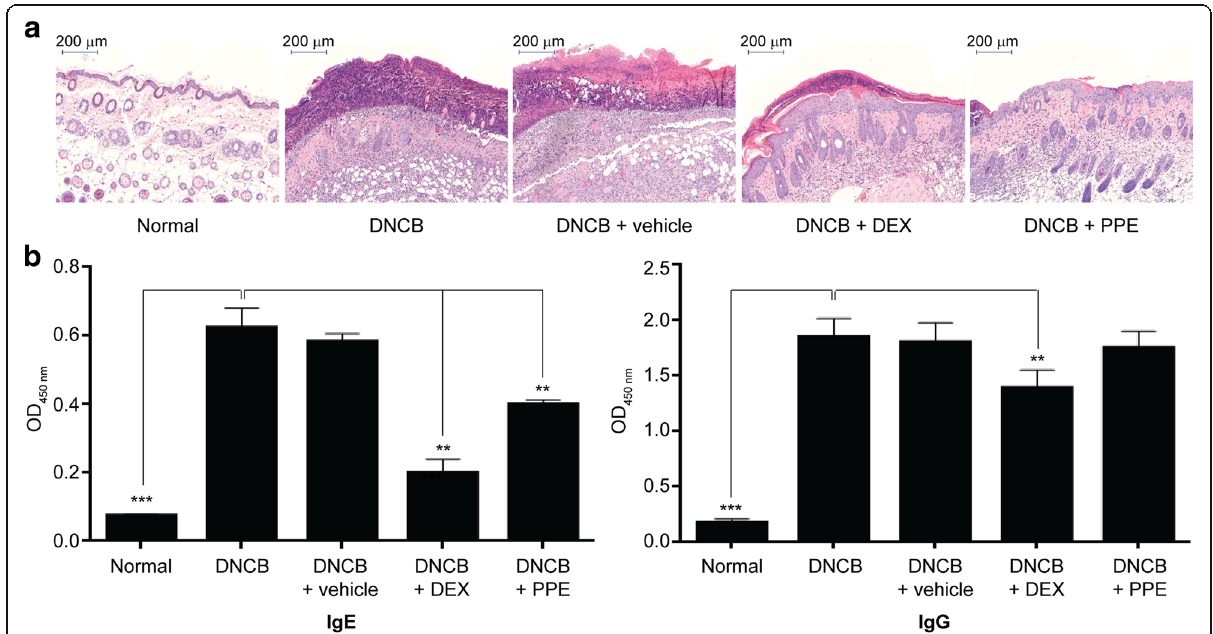
Fig. 3 Inhibitory effect of PPE on DNCB-induced inflammation based on histological analyses and serum IgE levels. ( a ) Histopathological changes in mouse dorsal inflammatory lesions were analyzed via H&E staining. Abnormal thickening of the epidermis along with severe keratinization and massive infiltration of immune cells were observed in DNCB-treated mice. Co-treatment with PPE significantly suppressed epidermal hyperplasia whereas cream alone had no effect. DEX treatment was used as a positive control. ( b ) IgE and IgG levels. Serum IgE and IgG contents were measured using ELISA kits. Both IgE and IgG levels were significantly enhanced (up to 9-fold) following DNCB treatment. Only allergen-specific IgE levels were significantly reduced after PPE treatment whereas IgG levels were maintained. Cream (vehicle) alone had no suppressive effect on either IgE or IgG levels. Results are presented as means ± SD of independent biological replicates ( n = 3). The two-tailed student t -test was used to evaluate the statistical significance of differences between DNCB-treated and normal, PPE or DEX-treated groups (** P < 0.01, *** P <